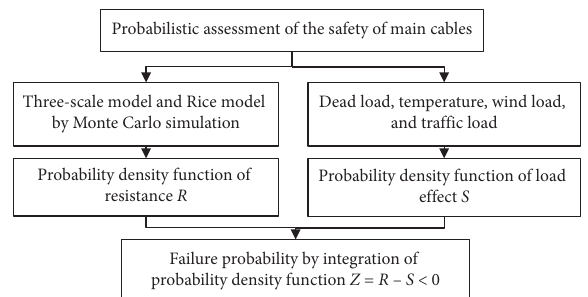
Probability density function of load effect S